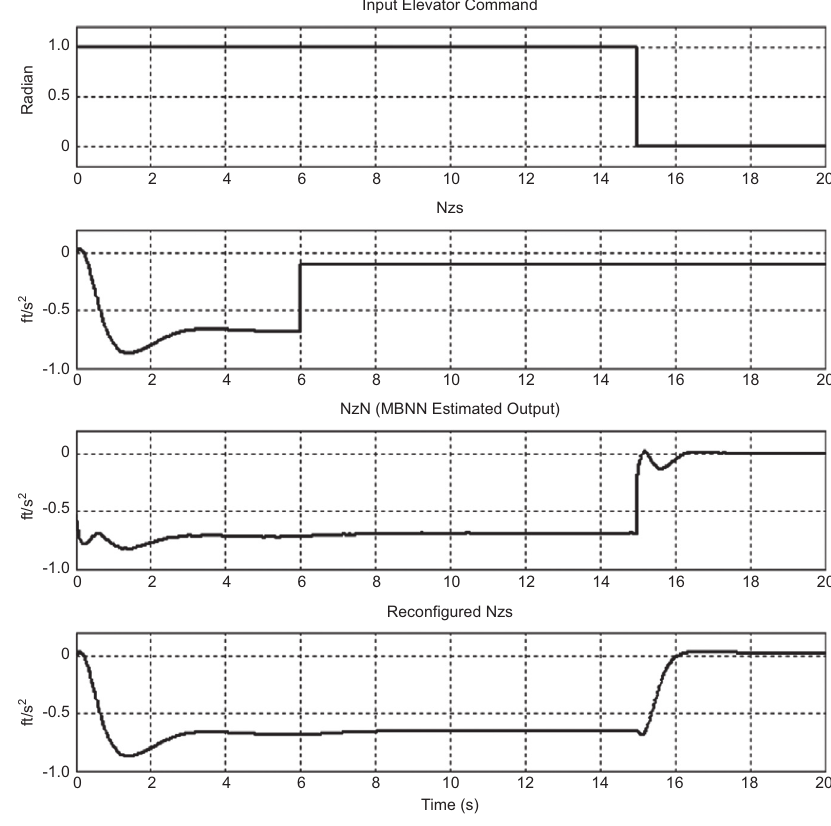
Figure 8. SFDA for Stuck Fault of “–0.1” at 6